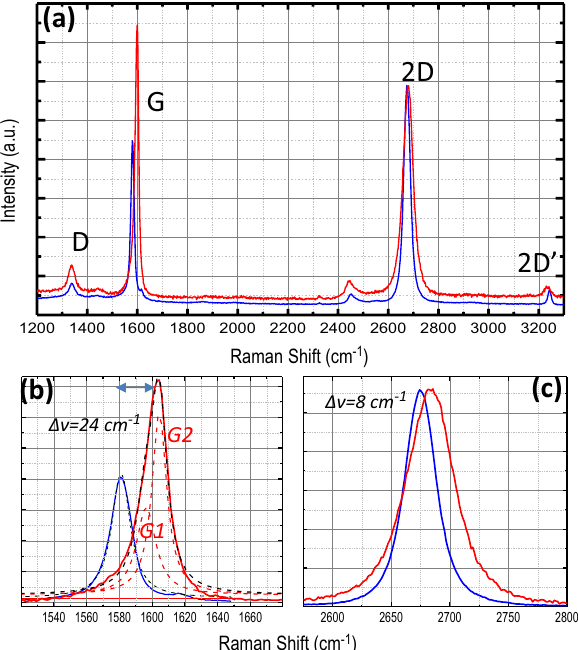
Figure 6. ( a ) Raman characterization of single layer graphene:N on Si/SiO 2 before (blue line) and after (red line) irradiation by Xe-lamp (150 min). Spectra are normalized to the 2D peak. ( b ) Details of the G-peak Lorentzian-fit analysis. The asymmetric G peak of the sample after Xe-lamp irradiation and, consequently, the deconvolution in two peaks G1 and G2 (dashed lines) indicate charge inhomogeneity within the laser probe. ( c ) Details of 2D peaks showing the perfect symmetry and low up-shift after Xe-lamp